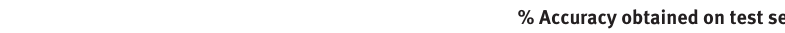
Table 3. Classification Results (%) Obtained for Stops in CV Syllables Extracted from the Test Set of the VTR Formant Database.